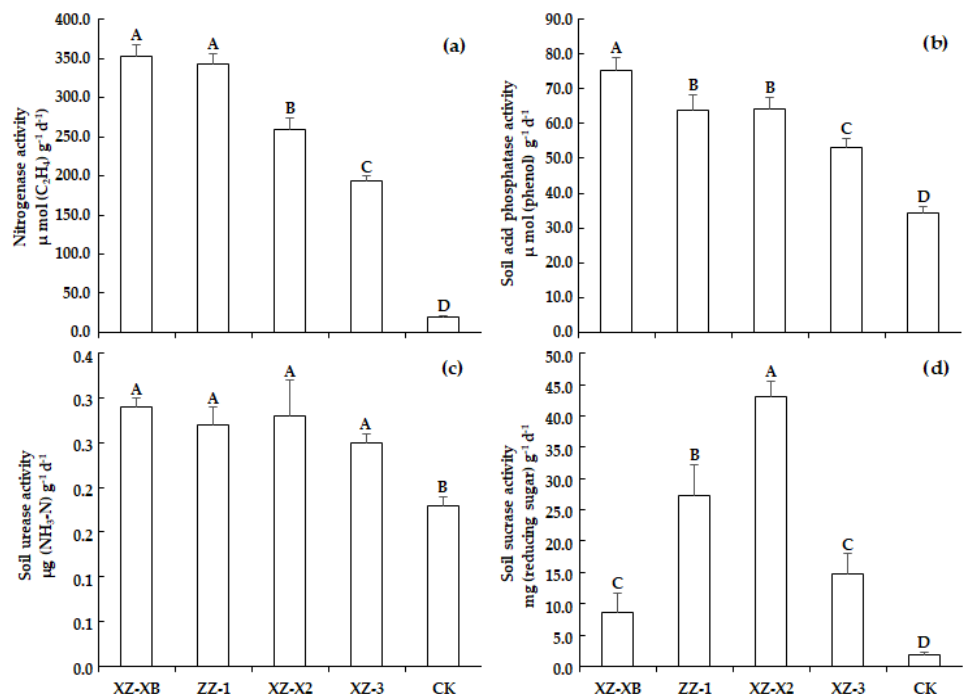
Figure 2. Comparison of the soil enzyme activity of nitrogenase ( a ), acid phosphatase ( b ), urease ( c ), and sucrose ( d ) between different ramie germplasms. Different capital letters within each measured trait indicate least significant differences at p < 0.01 level. XZ-XB, Xiangzhu XB; ZZ-1, Zhongzhu 1; XZ-X2, Xiangzhu X2; XZ-3, Xiangzhu 3. CK is the control without ramie cultivation.